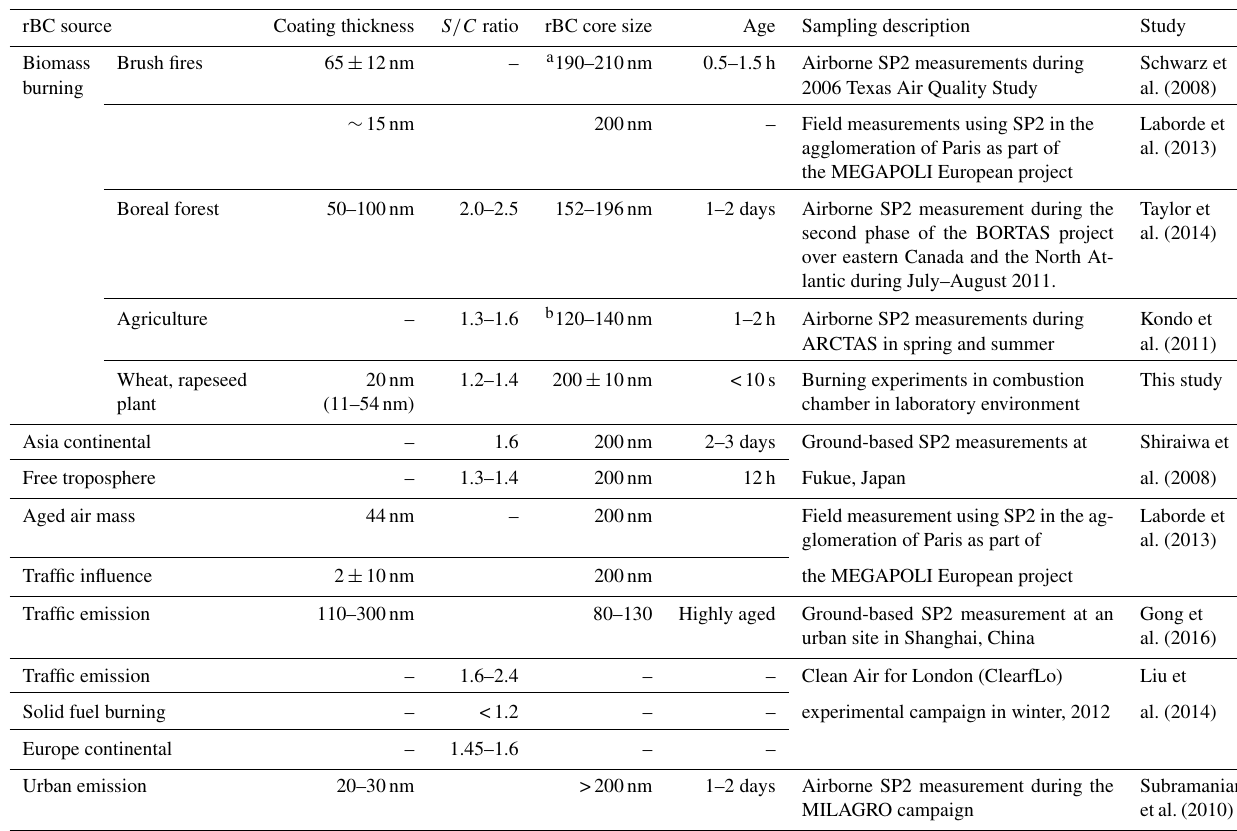
Table 3. Brief summary of the coating thickness and shell/core ( S/C ) ratios for rBC emissions from different sources collected from recent